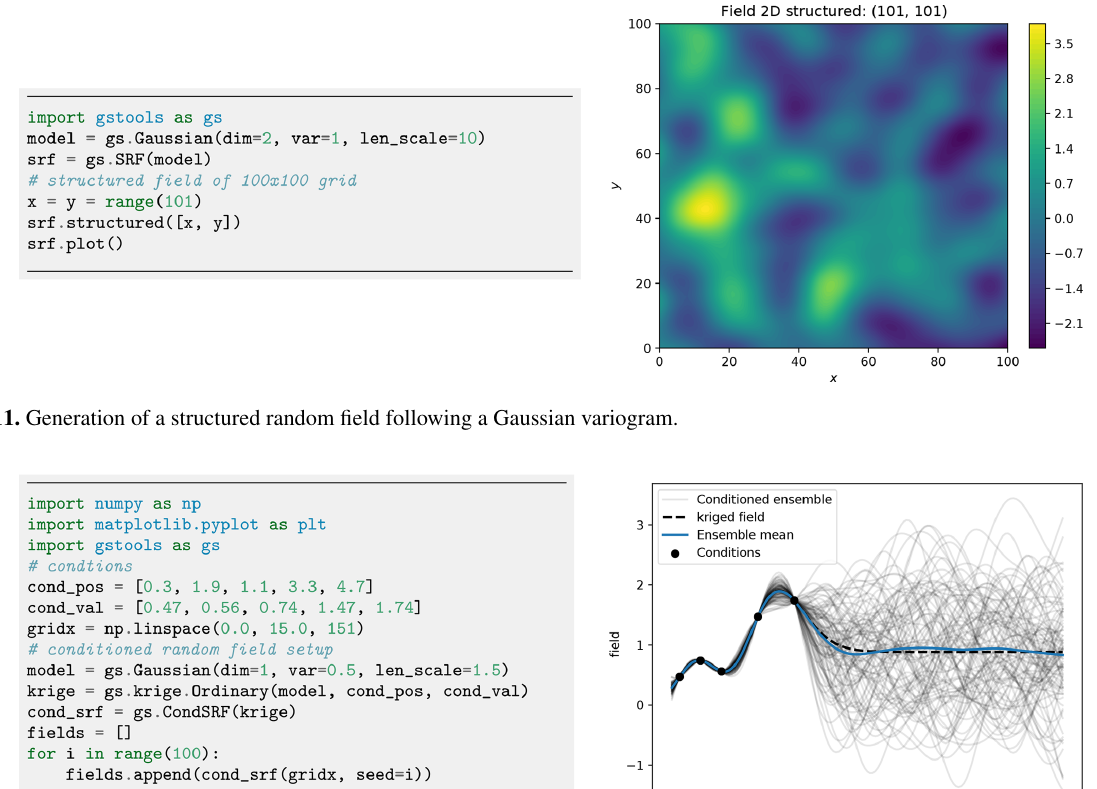
and E 0 = (e i 0 ) T at the target point, where l is the i = 1 ...l